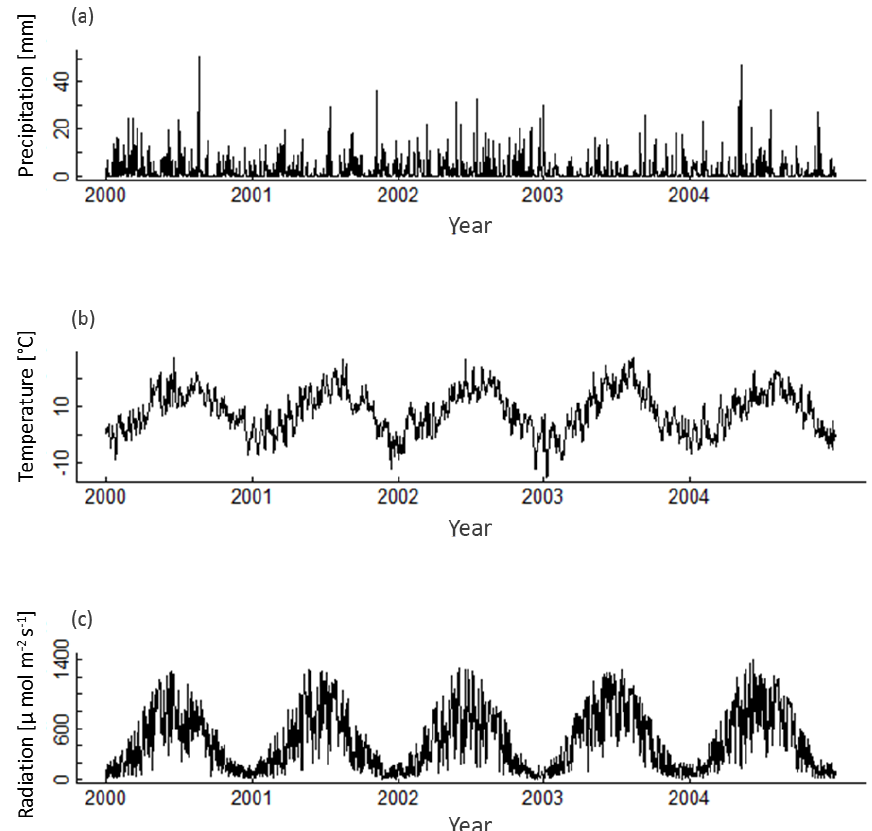
Figure A1. The climate time series measured at FLUXNET Hainich station from 2000 to 2004 which are used to generate the 320 climate time series: (a) daily precipitation (mm), (b) daily air temperature (% ◦ C − 1 ), (c) daily incoming radiation (photoactive photon flux density, µmolm − 1 s − 1